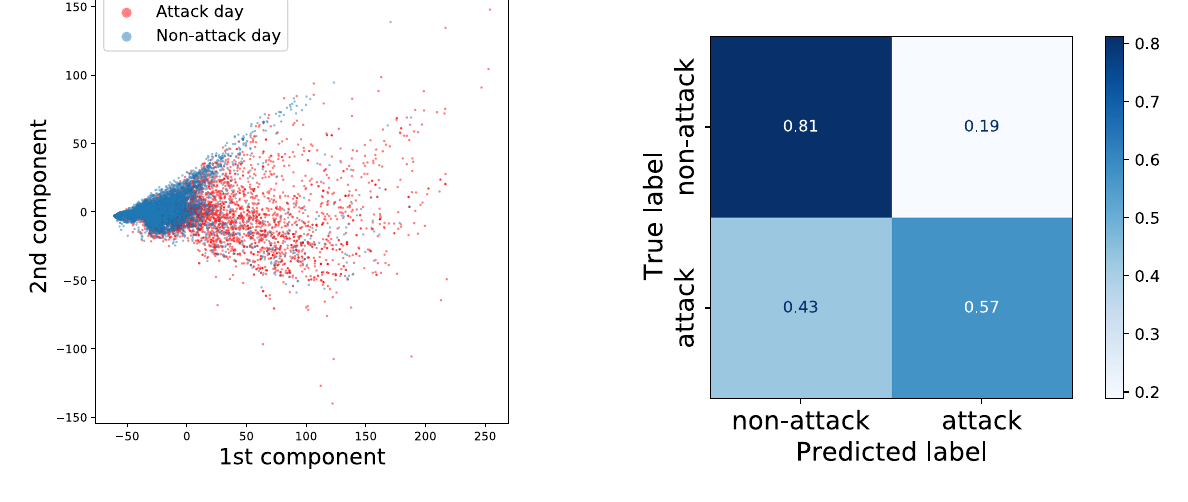
Figure 9. (Left) First two components of PCA dimensionality reduction on the risk data consisting of the four variables ( C , I , c and i ). The component loadings are shown in Table 1. Difference of the two classes in the plot indicates that a level of separability exists in the dataset. (Right) Confusion matrix obtained by training and testing a logistic regression classifier on the proposed risk measures. The overall accuracy of the classifier was around 0.69 and F1 score was